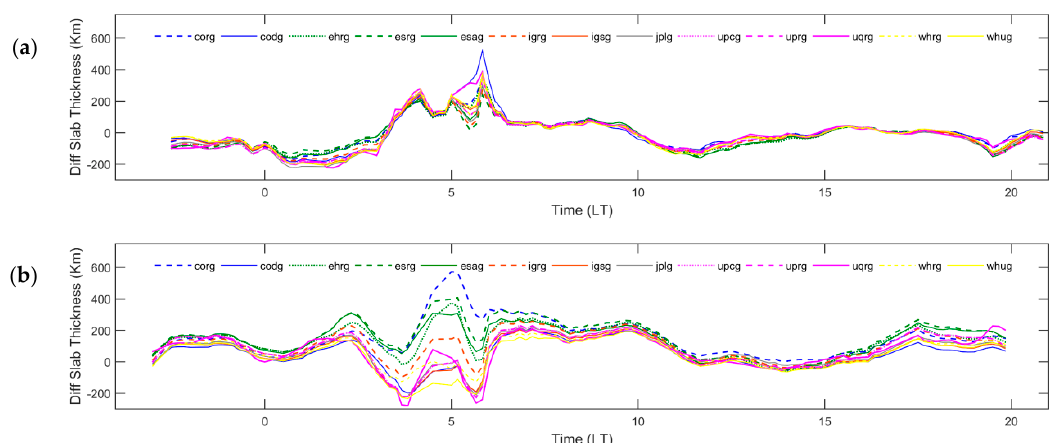
Figure 6. Differences between fo F 2 values measured at the ionosondes and estimated using GIMs, for two pairs of ionosondes: ( a ) FZA0M and SAA0K, the closest one; ( b ) CAJ2M and BVJ03, the most distant one.